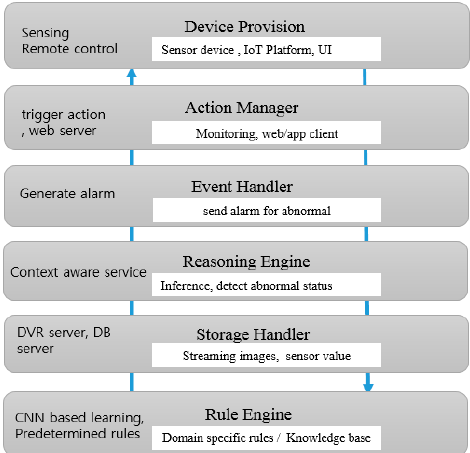
Figure 5. Architecture of the IoT platform with an intelligent monitoring system.